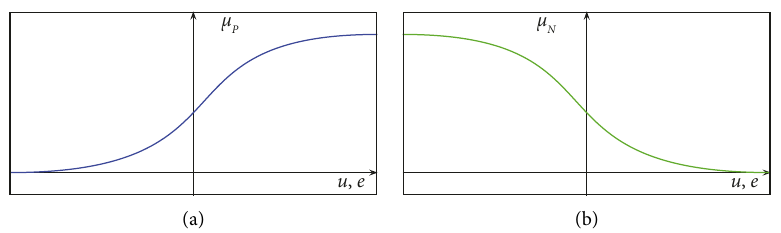
Figure 8: Fuzzy sets are employed to model positive and negative values. (a) A fuzzy set is employed to model positive values. (b) A fuzzy set is used to model negative values.